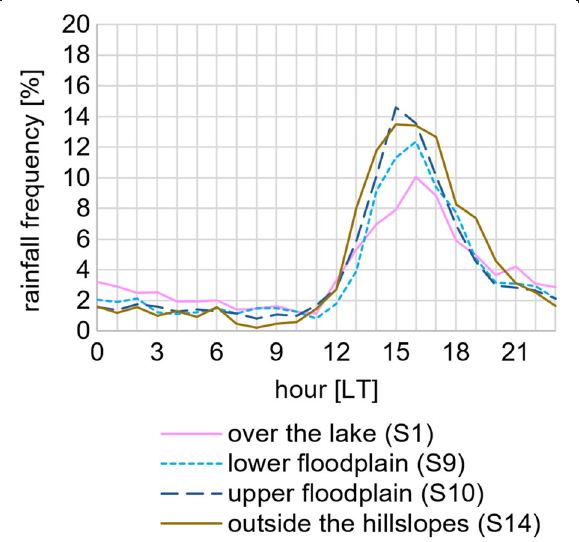
Fig. 6 Same as Fig. 5b but for each station at S1 (over the lake), S9 (lower floodplain), S10 (upper floodplain), and S14 (away from the mountain hillslopes)